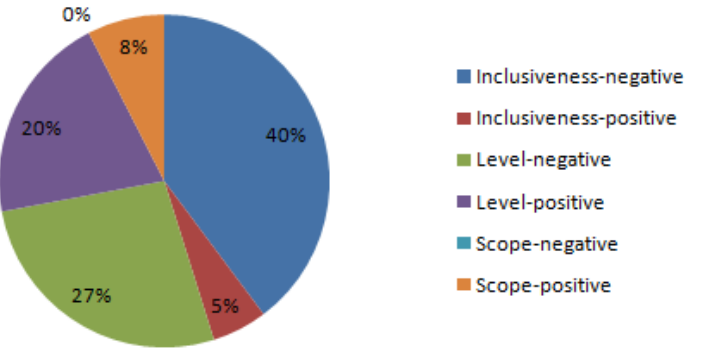
Figure 8. Future of the EU (n = 93).